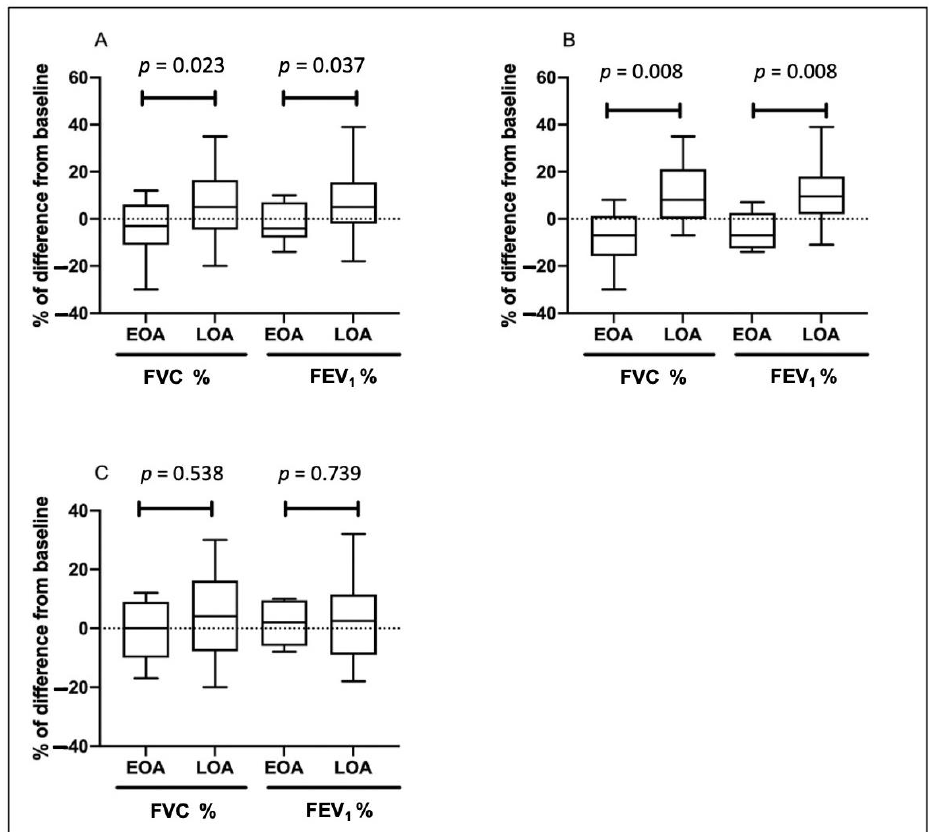
Figure 2. Change of forced vital capacity (FVC) and forced expiratory volume in 1 s (FEV 1 ) in patients with early-onset asthma (EOA) and late-onset asthma (LOA) after 12-month treatment in the total cohort ( A ), patients <65 years old ( B ), and patients ≥ 65 years old ( C ). Boxplots show the median (bar), the first and third quartiles (box), and the 1st and 99th percentiles (whiskers) of the biomarkers level for each asthma